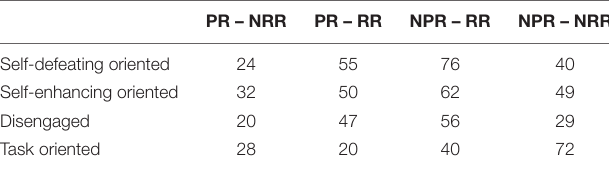
comparison with the PR – NRR group and p < 0.001 for